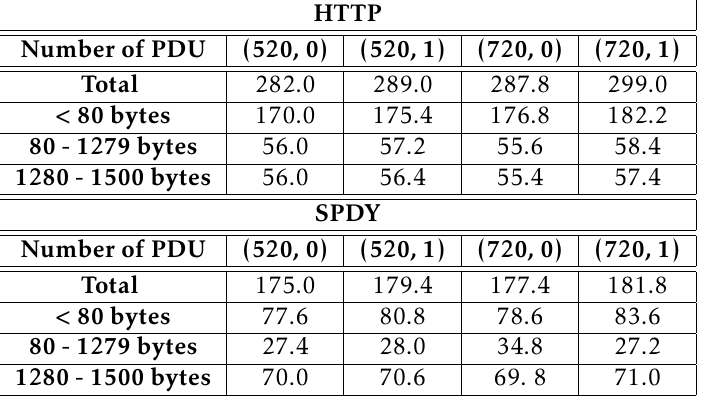
Table 4. Packet Size Analysis for Wikipedia – HTTP vs SPDY. Different trials are referred to (RTT [ms], ploss [%]).